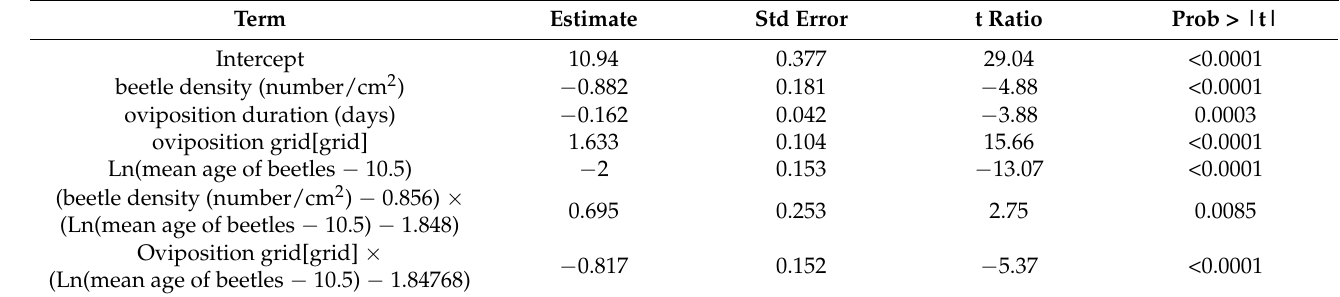
Table 5. Parameter estimates, standard error and significance level (t ratio and p -value) for multi- ple linear regression model of the number of eggs per beetle per day for experiment 2.